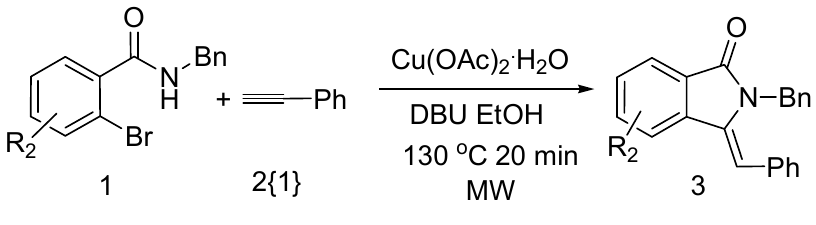
Table 3. Synthesis of substituted (Z)-2-benzyl-3-benzylideneisoindolin-1-one a